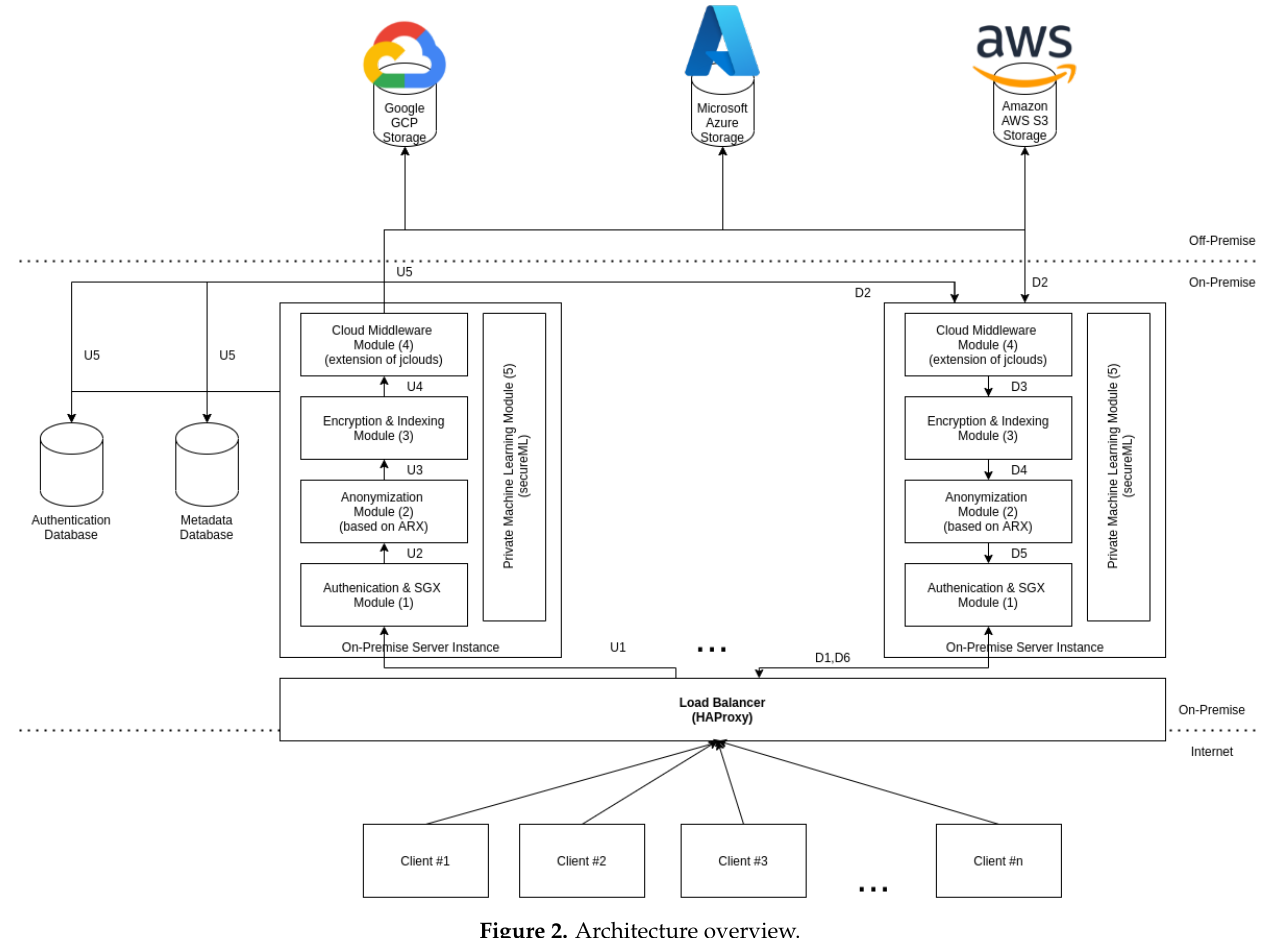
Figure 2. Architecture